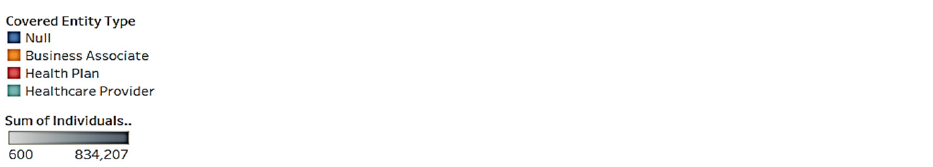
Figure 24. Geographical distribution by the entity type.